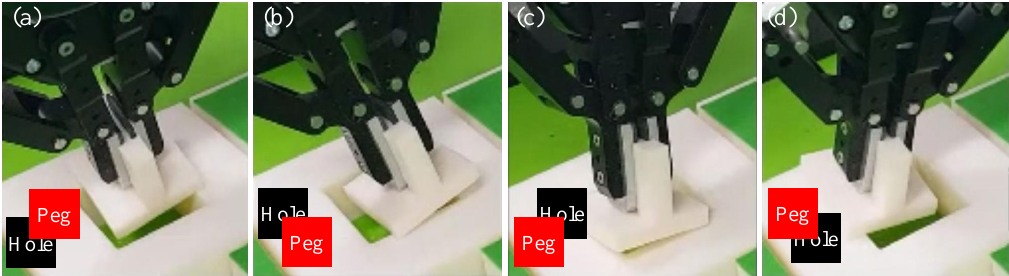
Figure 3. Different demonstrations according to relative positions/directions of the peg and hole: pegs and holes at directions of: ( a ) 30 ◦ ; ( b ) 120 ◦ ; ( c ) 210 ◦ ; and ( d ) 300 ◦ . Here, these directions represent the relative positions of the peg relative to the hole. The black and red boxes indicate the hole and the peg, respectively. The human needs to provide the corresponding demonstrations according to these configurations, and the robot learns different reaction force/moment signals and reaction motion trajectories from these demonstrations.